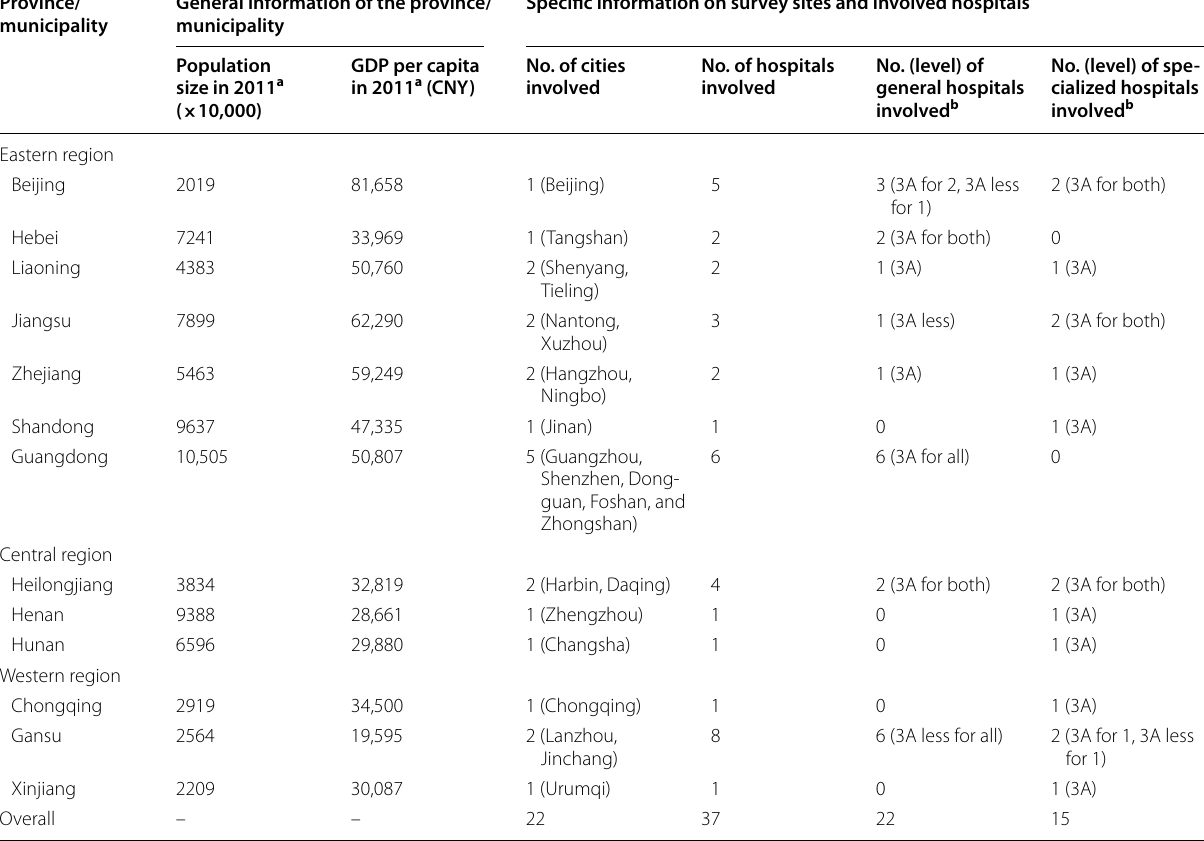
a Based on the China Statistical Yearbook 2012, http://www.stats.gov.cn/tjsj/ndsj/2012/indexch.htm